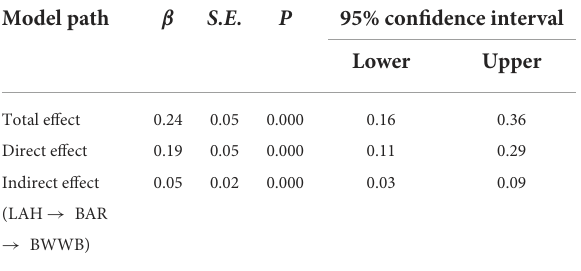
TABLE 3 Test results of mediation effect of bystander affective rumination.